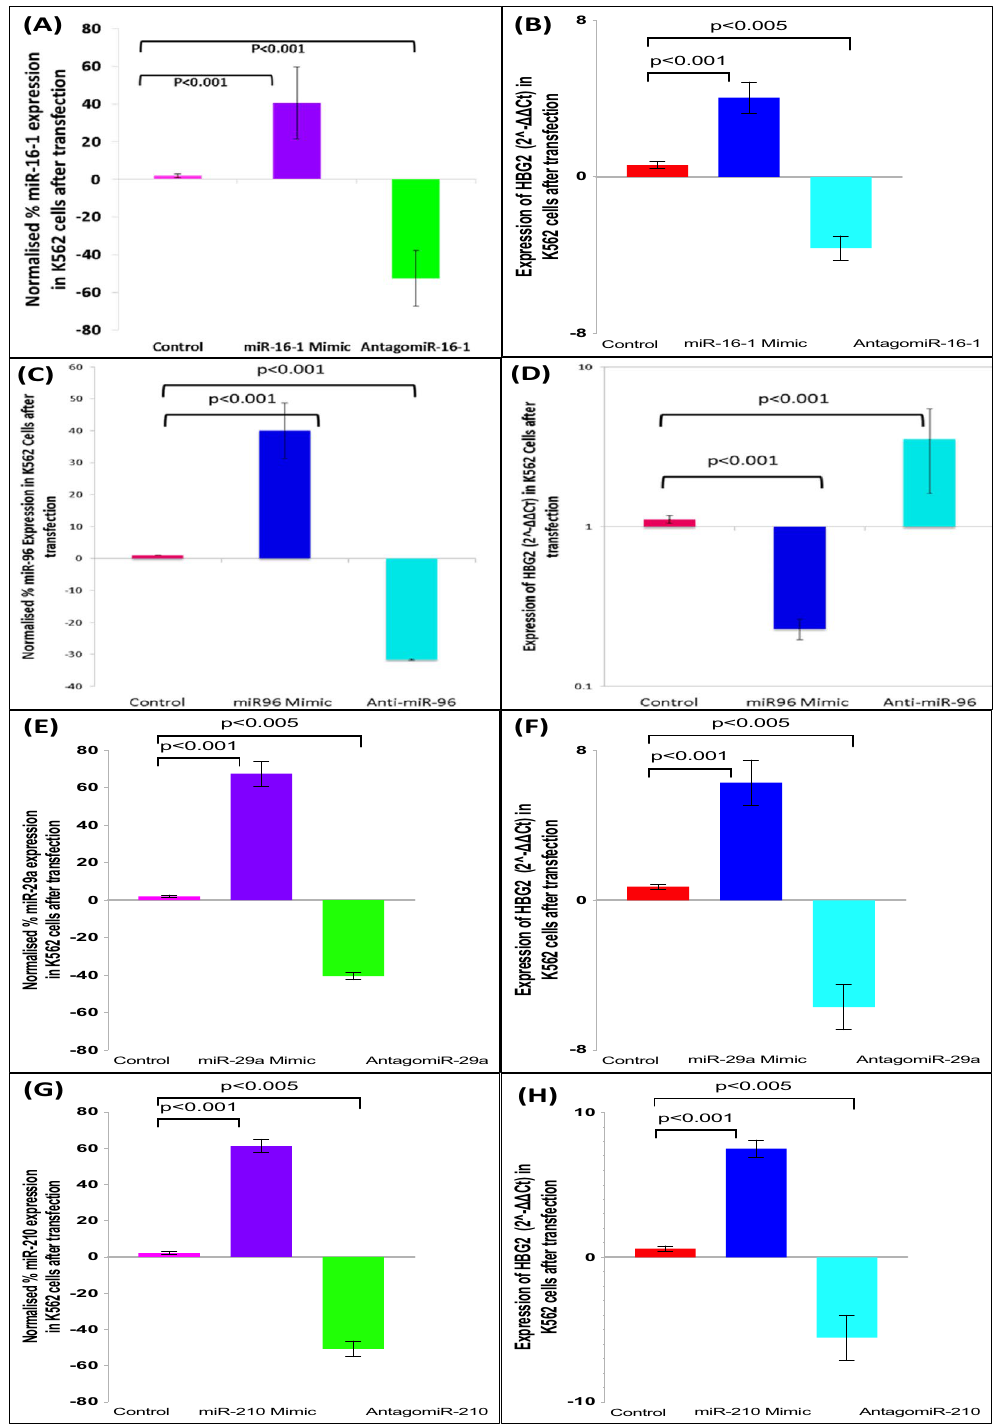
Figure 4. Transfection of mimics and Antagomir in K562 cells. ( A ) Transfection with miR-16-1 mimic and AntagomiR ( B ) HBG2 expression after transfection miR-16-1. ( C ) Transfection with miR-96 mimic and AntagomiR ( D ) HBG2 expression after transfection with miR-96. ( E ) Transfection with miR-29a mimic and AntagomiR ( F ) HBG2 expression after transfection miR-29a. ( G ) Transfection with miR-210 mimic and AntagomiR ( H ) HBG2 expression after transfection